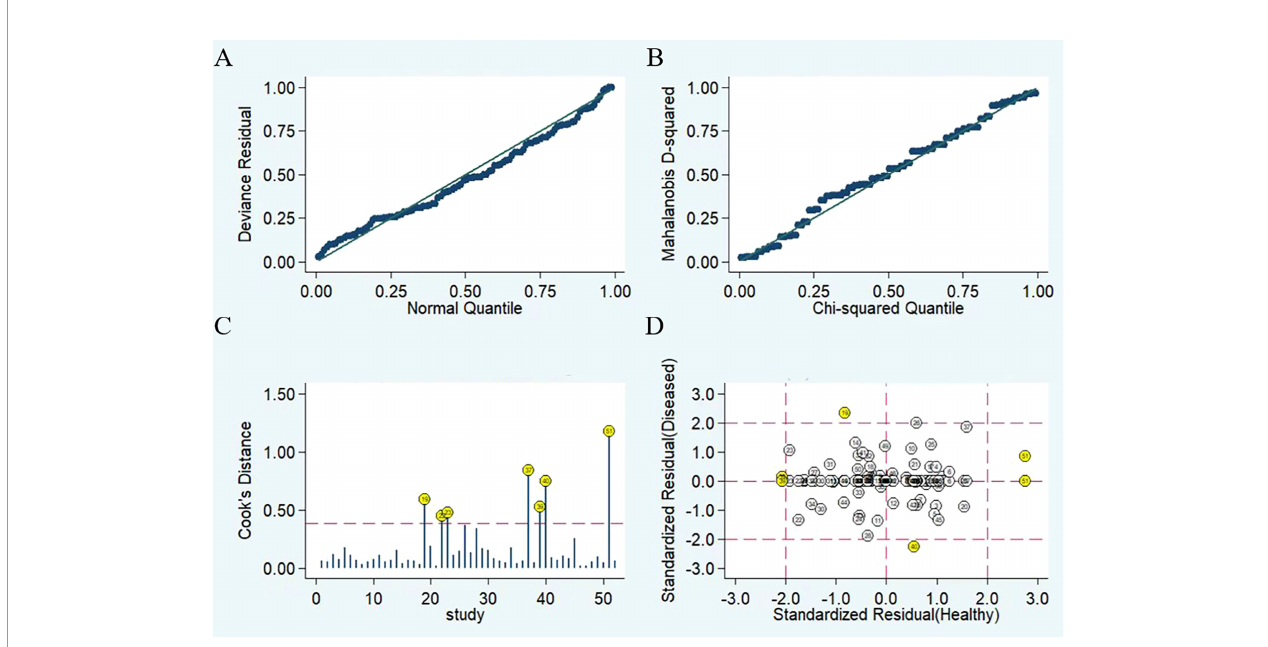
FIGURE 6 | Diagram of sensitivity analysis showing (A) goodness-of- fi t; (B) bivariate normality; (C) in fl uence analysis; (D) outlier